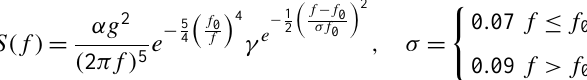
Fig. 13: The HONLS eqn. with nonlinear damping 0 < β < 0 . 75 , u = a (1 + 0 . 01cos µx ) , 0 . 57 < a < 0 . 67 , (a) spectral 0 center k at t = 200 , (b) max m rogue waves, and (d) time of last rogue wave as a function of β . The solid curves represent the averages.